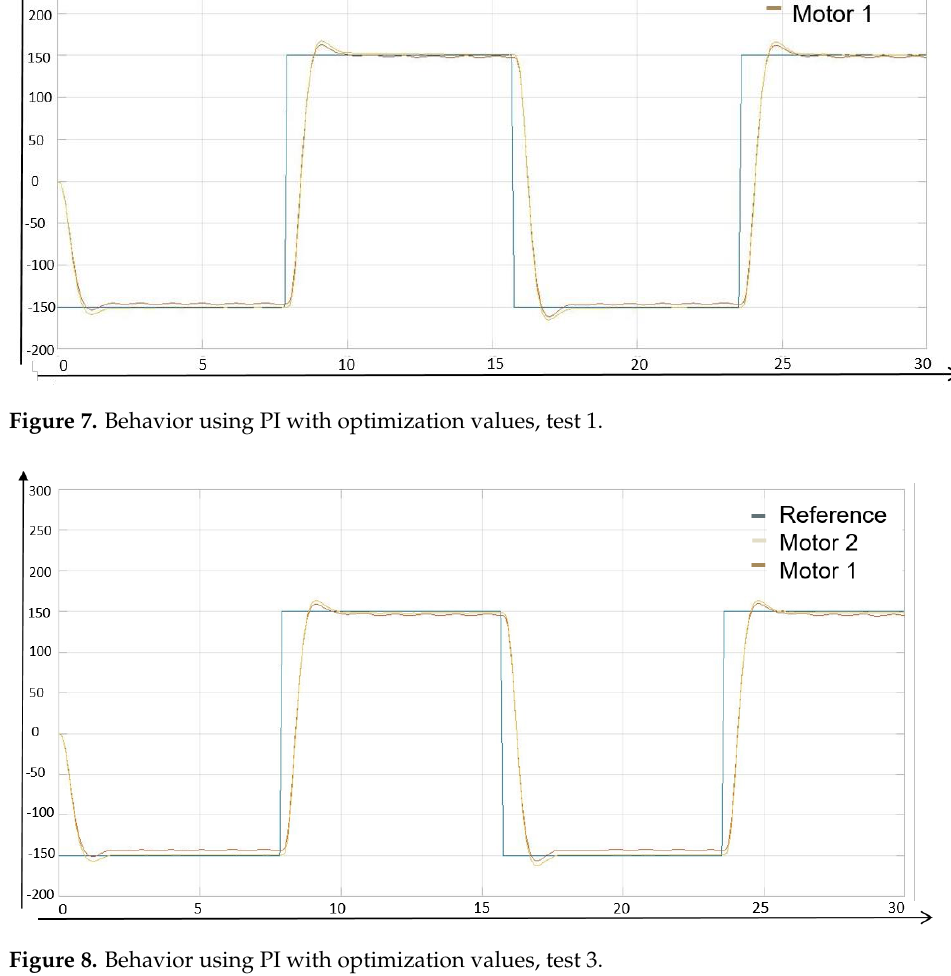
Figure 8. Behavior using PI with optimization values, test 3. Table 3. Comparison using PI traditional and intelligent PI